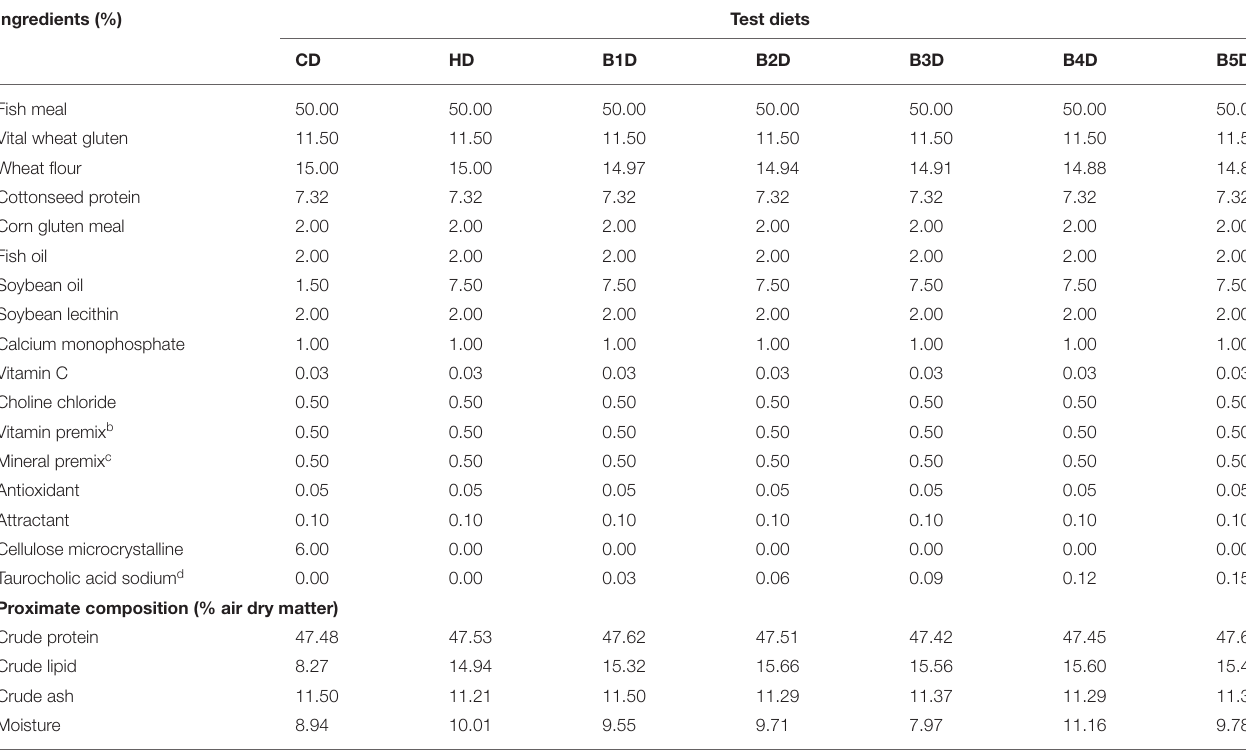
TABLE 1 | Composition and concentration of nutrients in diets a . Ingredients (%)